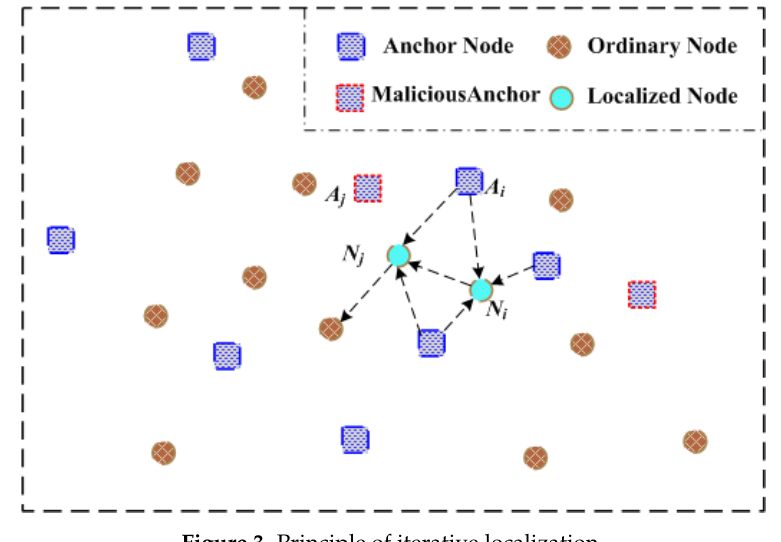
Figure 3. Principle of iterative